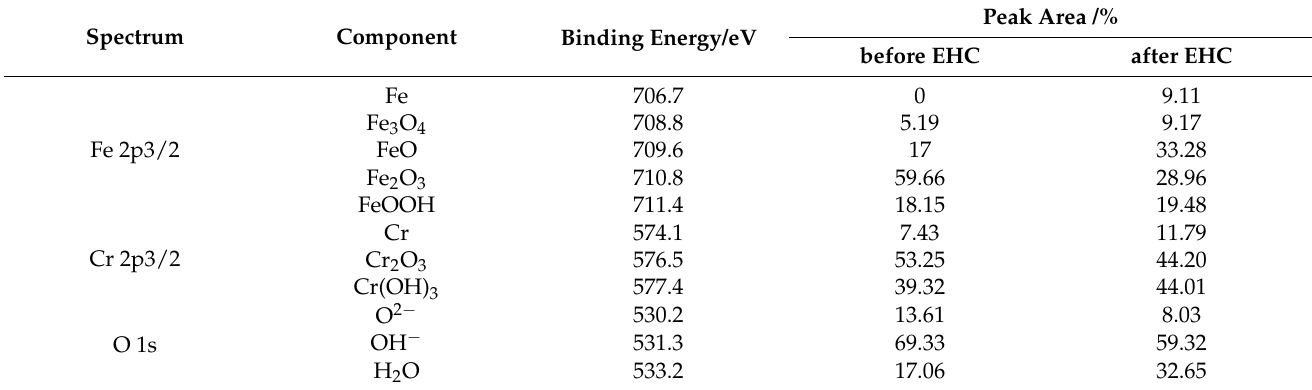
Table 2. The XPS peak positions and peak areas of different components of passive film.